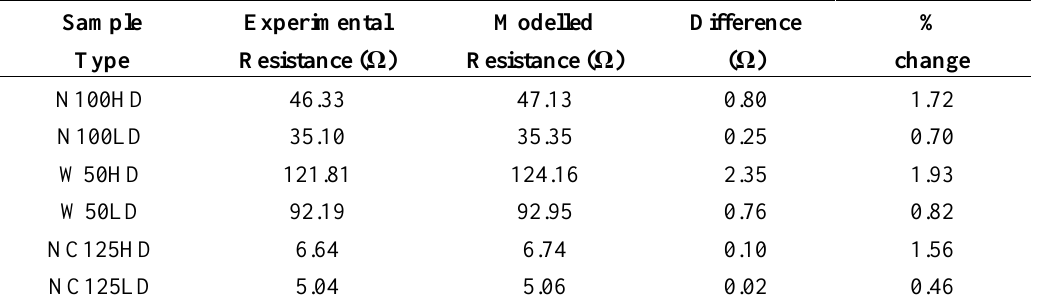
Table 2. Comparison of experimental and modelled reference resistance (at 20 °C).